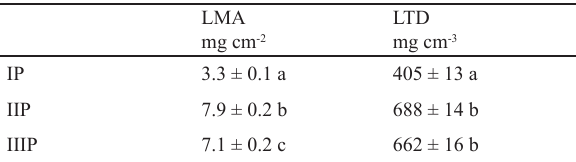
Table 1. Values of leaf mass per unit of leaf area (LMA, mg cm - 2 ) and leaf tissue density (LTD, mg cm -3 ) in the three phases considered during leaf development in Corylus . IP = first phase at developing leaf; IIP = second phase at fully developed leaf; IIIP = third phase at leaf senescence. Different letters indicate significant differences (ANOVA, p ≤ 0.05) across the three phases. Mean values (± SE) are shown (n = 50).